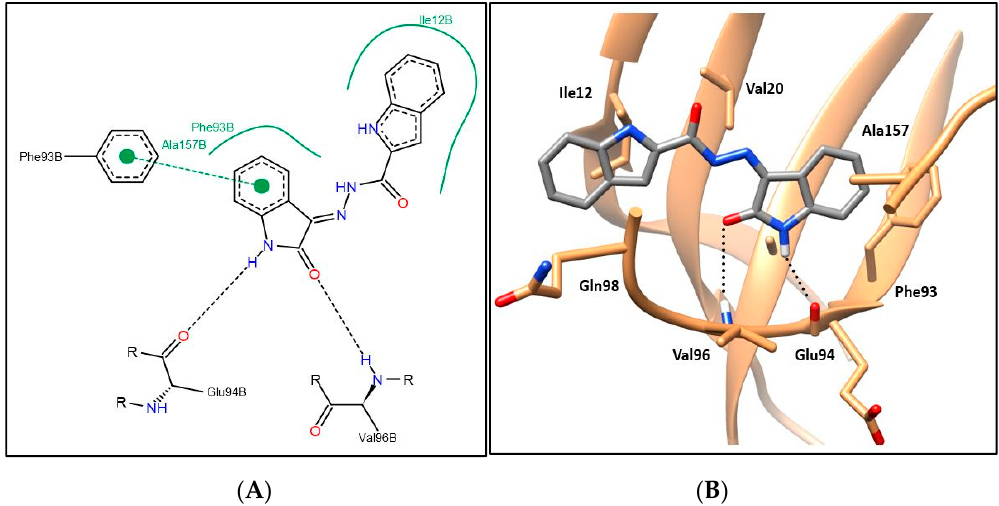
Figure 6. ( A ) The 2D diagram; ( B ) 3D representation for hybrid 6a displaying its interaction with the CDK4 binding site.